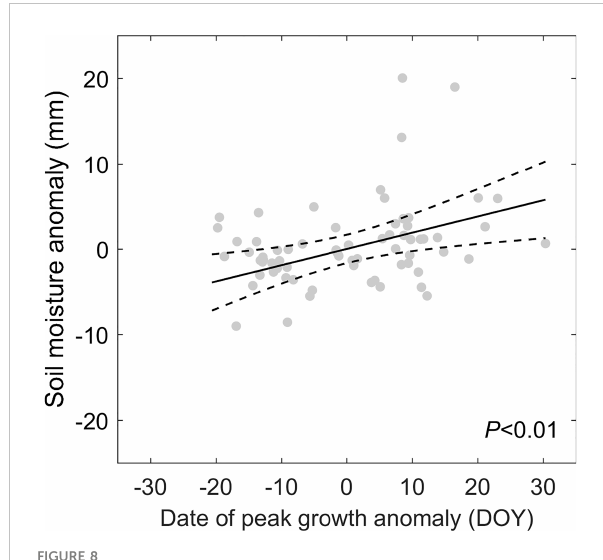
FIGURE 8 The partial regression plot for the relationship between the date of peak vegetation growth and soil moisture while controlling precipitation. The black line shows the regression line and the dash lines denote the 95% con fi dence